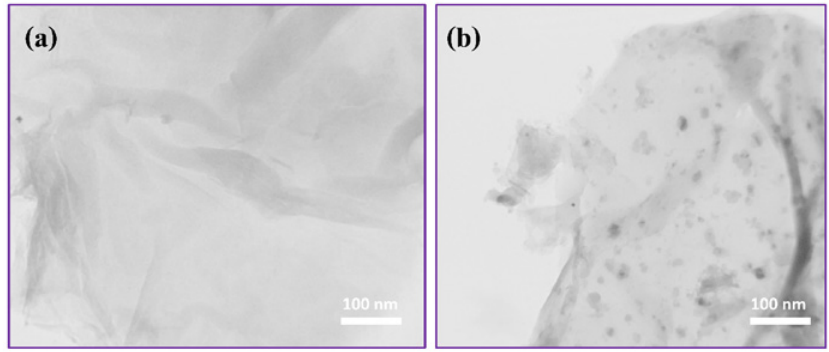
Fig. 3. TEM images of (a) graphene and (b) Ag-TiO